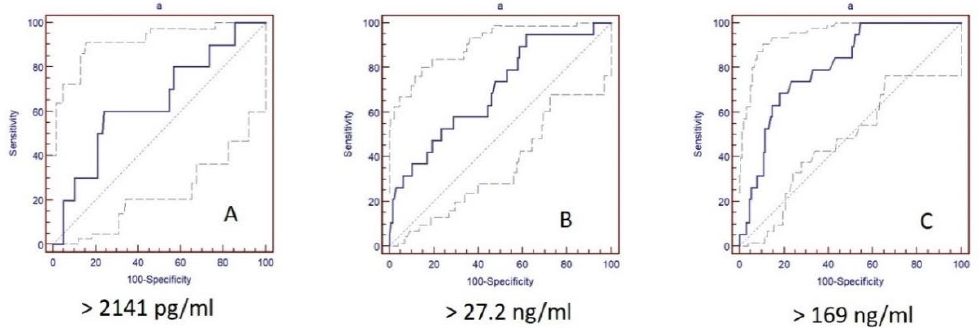
Figure 4. CV mortality cut-off values of the biomarkers NT-proBNP ( A ), ST2 ( B ) and Ptx-3 ( C ) in two-year FU after STEMI by ROC analyses.